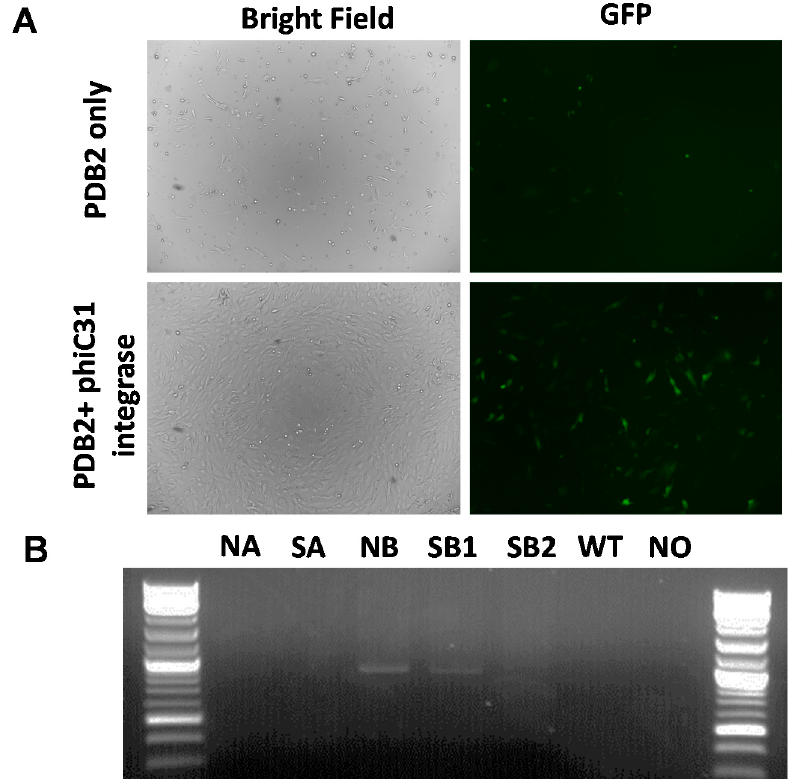
Figure 3. phiC31 integrase mediated integration of GFP transgene into COL1A targeted clonal lines. ( A ) Brightfield and fluorescent micrographs (100× magnification) showing integration and expression of GFP transgene in COL1A knockin lines in the absence ( top panel) or presence of integrase ( bottom panel); ( B ) PCR amplicons showing targeted knockin of GFP transgene into the target sites. The cells following nucleofection and G418 selection and sorting were analyzed by PCR. Amplicons that show knockin were identified only in the presence of integrase and not in vector only treatment, wild type parent cells and no-template controls.